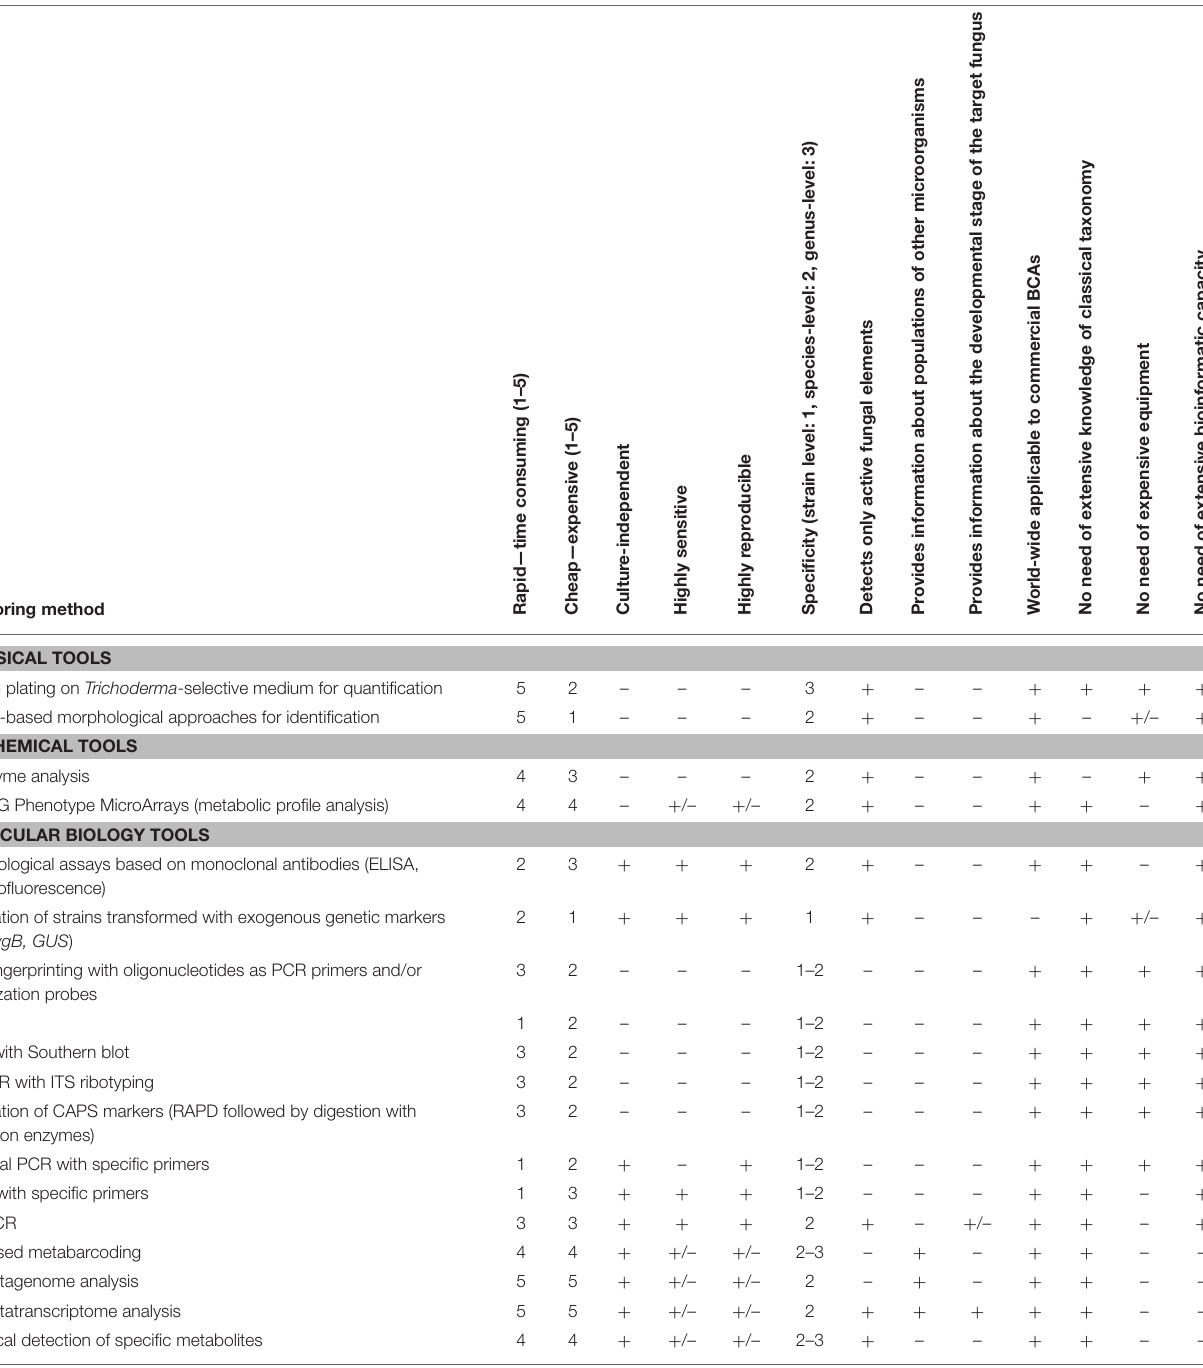
TABLE 3 | Critical evaluation of the advantages and limitations of techniques applicable for monitoring (detection and quantification) Trichoderma species/strains in agricultural